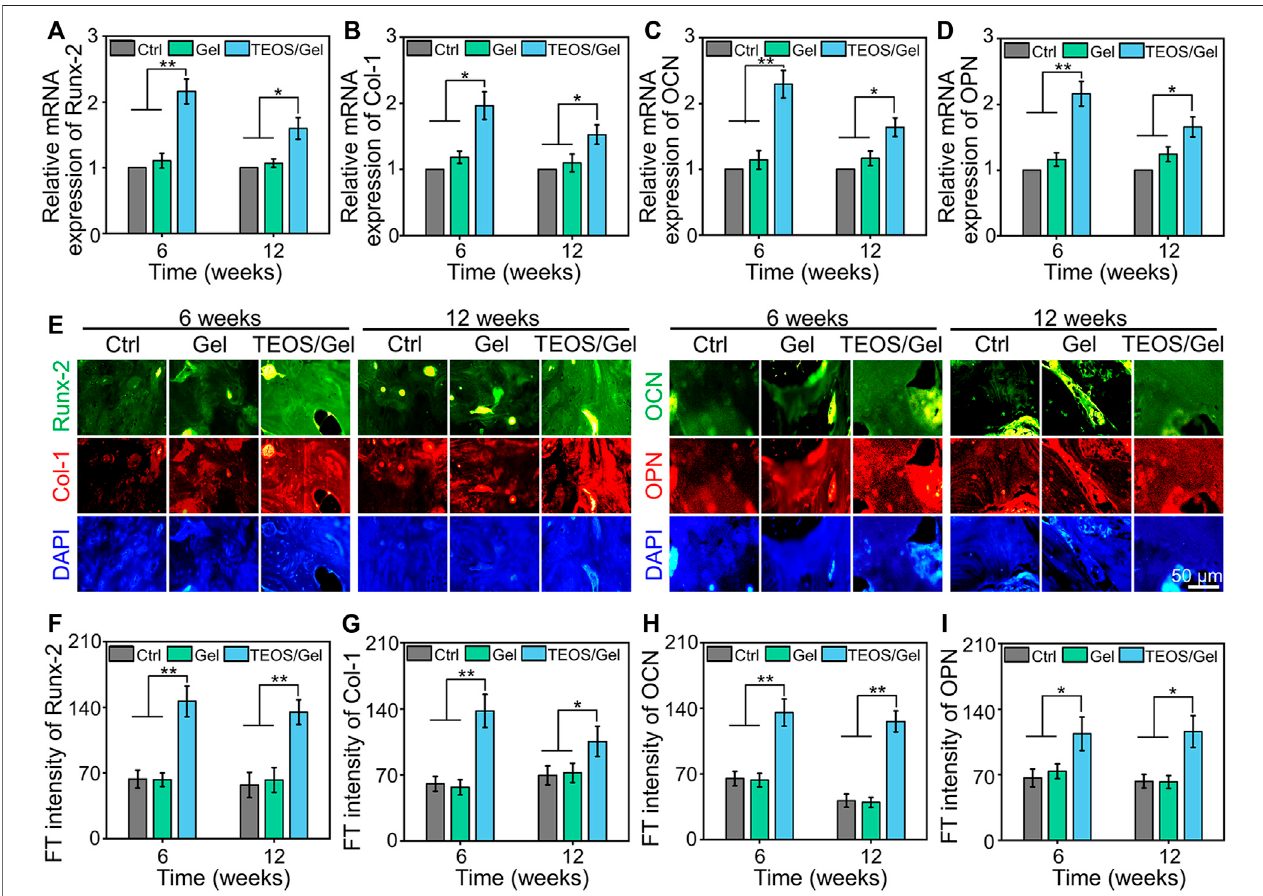
FIGURE 6 | TEOS hydrogel enhanced osteogenic-related marker expression. (A – D) RT-qPCR analysis of Runx-2 , Col-1 , OCN , and OPN in the regenerated bone tissues. (E) Representative immuno fl uorescence images. (F – I) Quantitative analysis of fl uorescence intensity of Runx-2, Col-1, OCN, and OPN in the regenerated bone tissues (* p < 0.05; ** p <